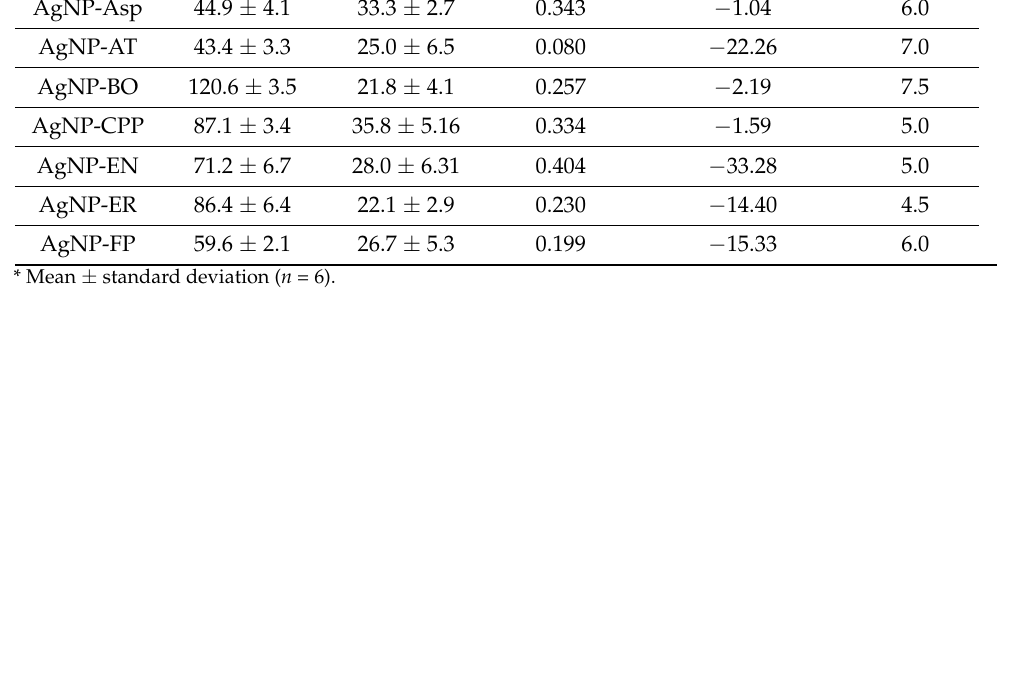
Table 1. Physicochemical properties of the AgNP-Asp, AgNP-AT, AgNP-BO, AgNP-CCP, AgNP- EN, AgNP-ER, and AgNP-FP: size (nm) by DLS and TEM, polydispersity index (PDI), zeta poten- tial, and pH values.